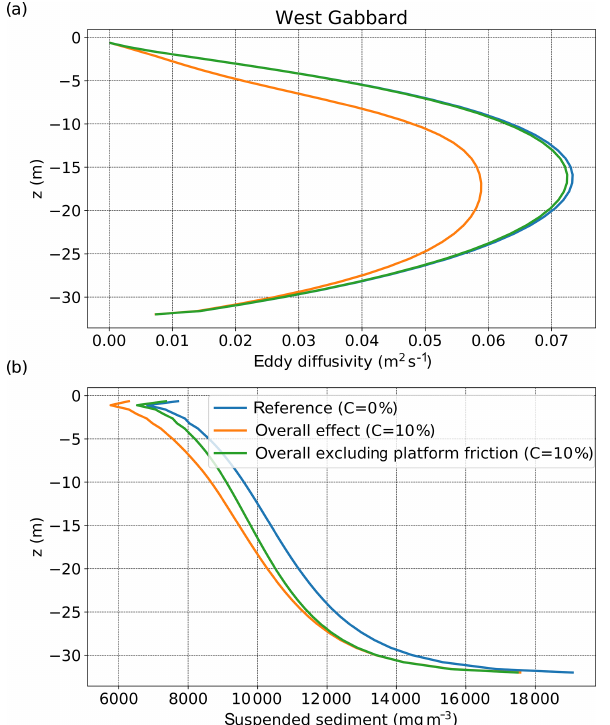
Figure 6. Vertical profiles of (a) eddy diffusivity and (b) suspended sediment concentration (averaged over 1998–2008) for the location of West Gabbard. The results are presented for the reference sce- nario (coverage of 0%) and for 10% coverage under the overall effect and the overall effect excluding platform friction.